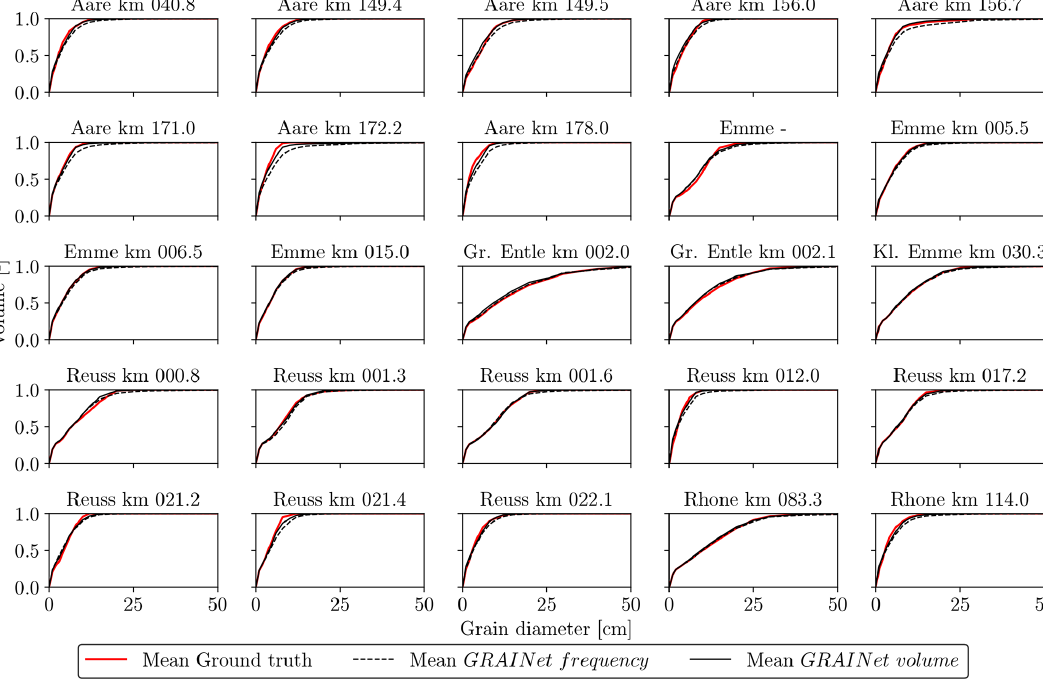
Hydrol. Earth Syst. Sci., 25, 2567–2597, 2021